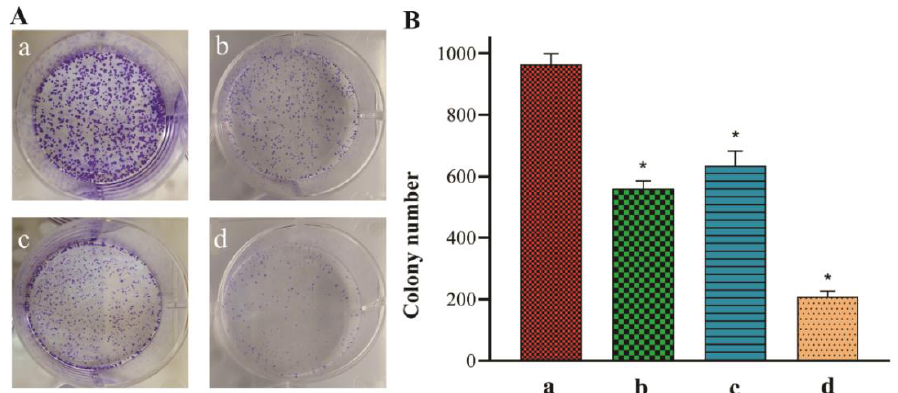
Figure 10. ( A ) Representative images of colony formation test in A549 cells with IC 50 concentrations of P. eldarica extracts and essential oil for 14 days; ( B ) Mean value of colony numbers showing inhibition in treated groups. a. Control group, b. pollen hexane extract-treated group (31.7 µ g/mL), c. bark essential oil-treated group (17.9 µ g/mL), and d. methanolic needle extract-treated group (0.3 µ g/mL). Data are expressed as mean ± standard deviation (SD), representative of three independent experiments. * p < 0.01 vs. control.